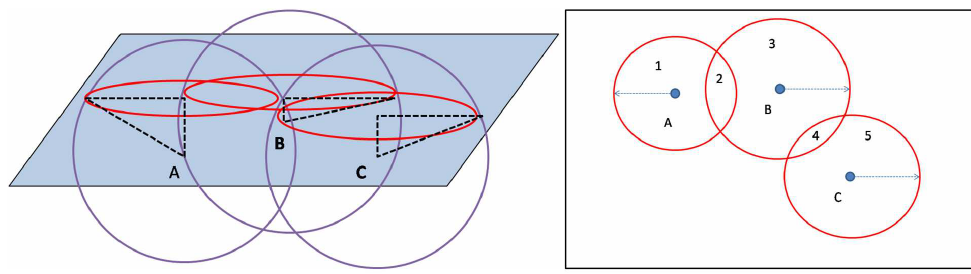
Figure 4. Initial deployment